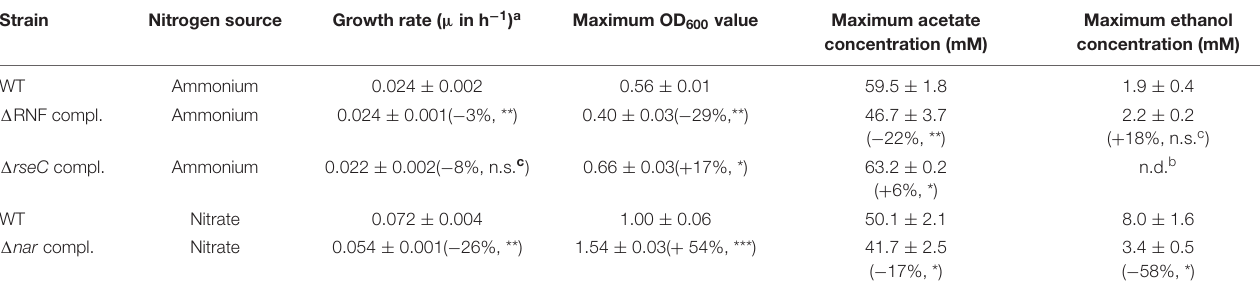
TABLE 2 | Performance of the plasmid-based complemented deletion strains of C. ljungdahlii in autotrophic batch cultivation experiments.